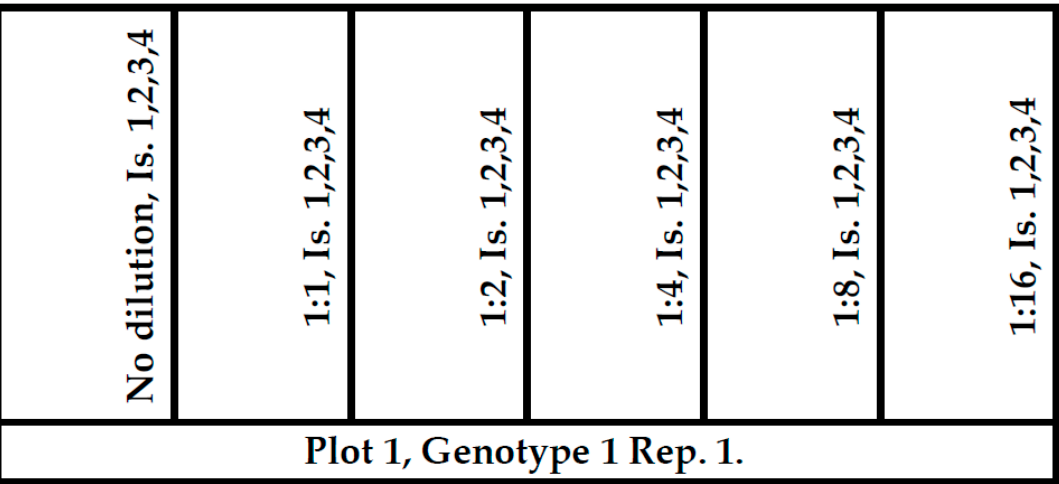
Figure 11. Map of a cultivar plot with six double rows and inoculation plan. The test in a year had 21 such plots. Dilutions: No, 1:1, 1:2, 1:4, 1:8, 1:16. Check = no dilutions, 1,2,3,4. Is = in the figure: Isolates used on groups of heads 1–4, 40–50 cm distance from each other.